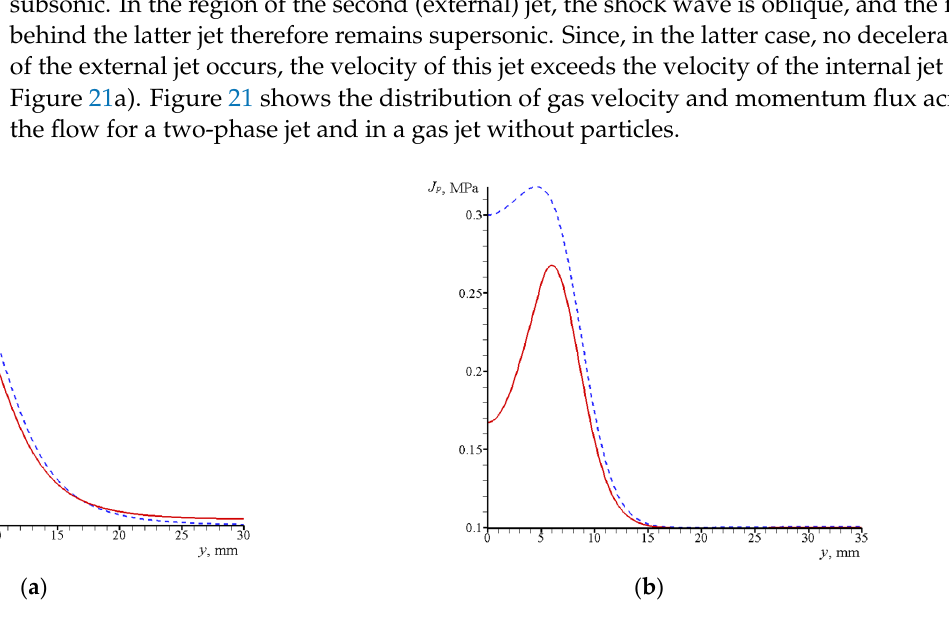
Figure 21. Dependences calculated in the transverse cross-section x = 70 mm: ( a )—velocity u ( y ) ( b )—momentum flux J p ( y ) . The solid line and the dashed line show the data for a two-phase jet and for a gas jet without particles, respectively.